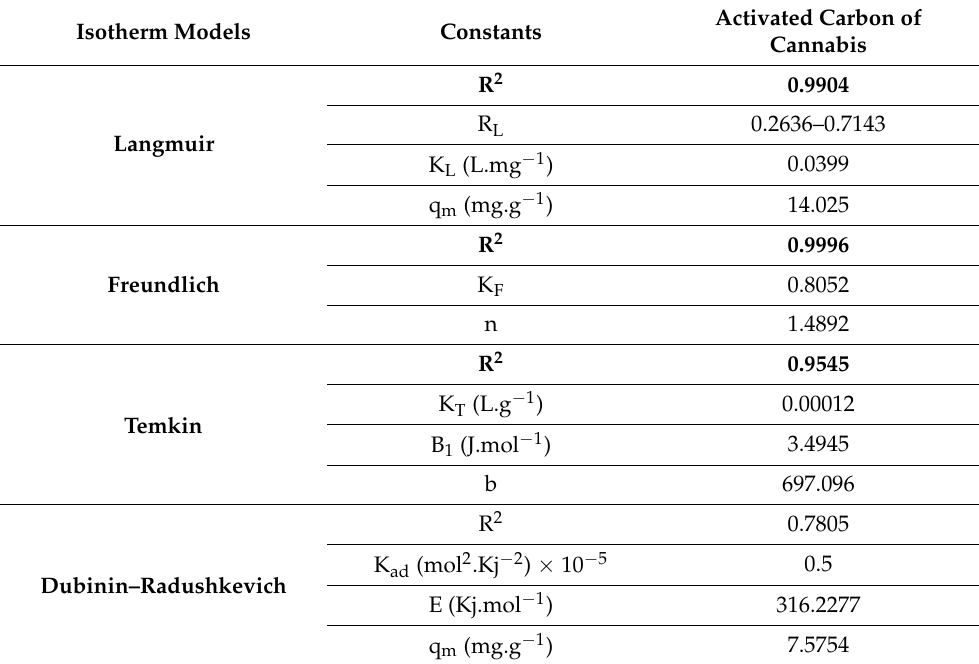
Table 2. Constant adsorption of four isotherms models of EBT dye on activated carbon of cannabis